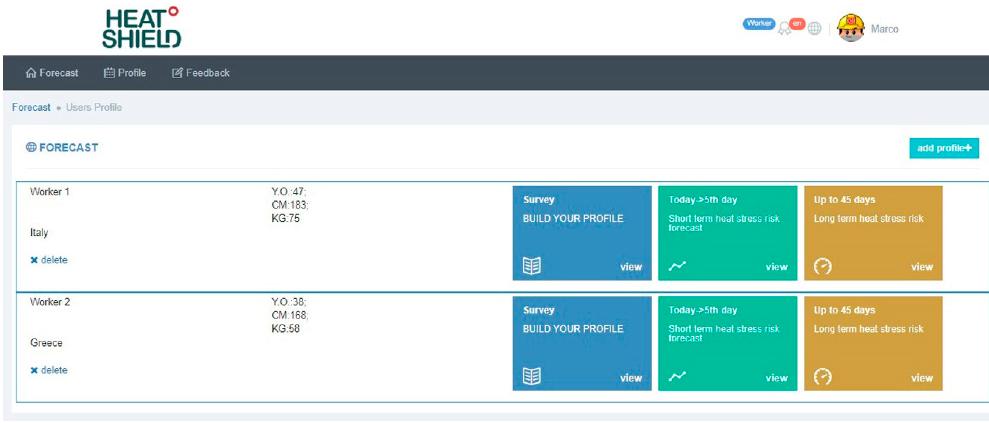
Figure 8. Page showing different worker’s profiles.